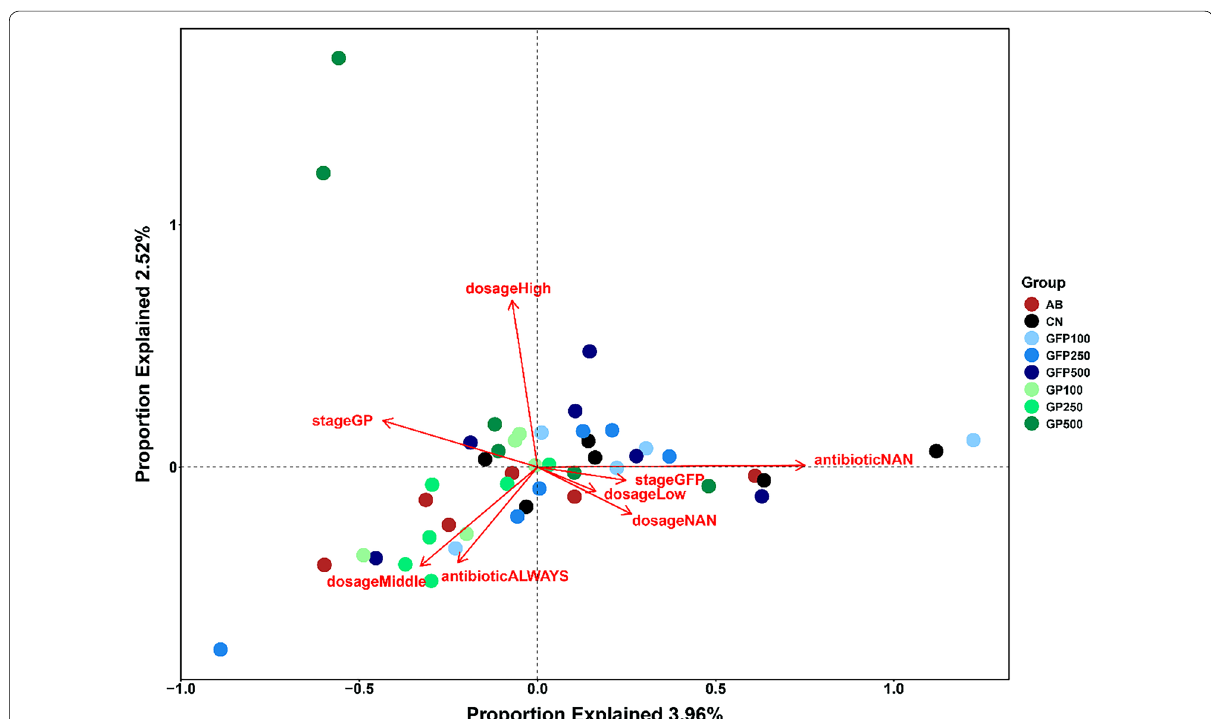
Fig. 5 Effects of different dietary conditions on the structure of microbial communities using RDA analysis. Dose NAN: no XOS addition; dose low: 100 g/t XOS addition; dose Middle: 250 g/t XOS addition; dose high: 500 g/t XOS addition; antibiotic NAN: no antibiotics and XOS addition; antibiotic ALYWAS: antibiotic addition only; stage GP: XOS addition during growing period; stage GFP: XOS addition during growing-fattening period